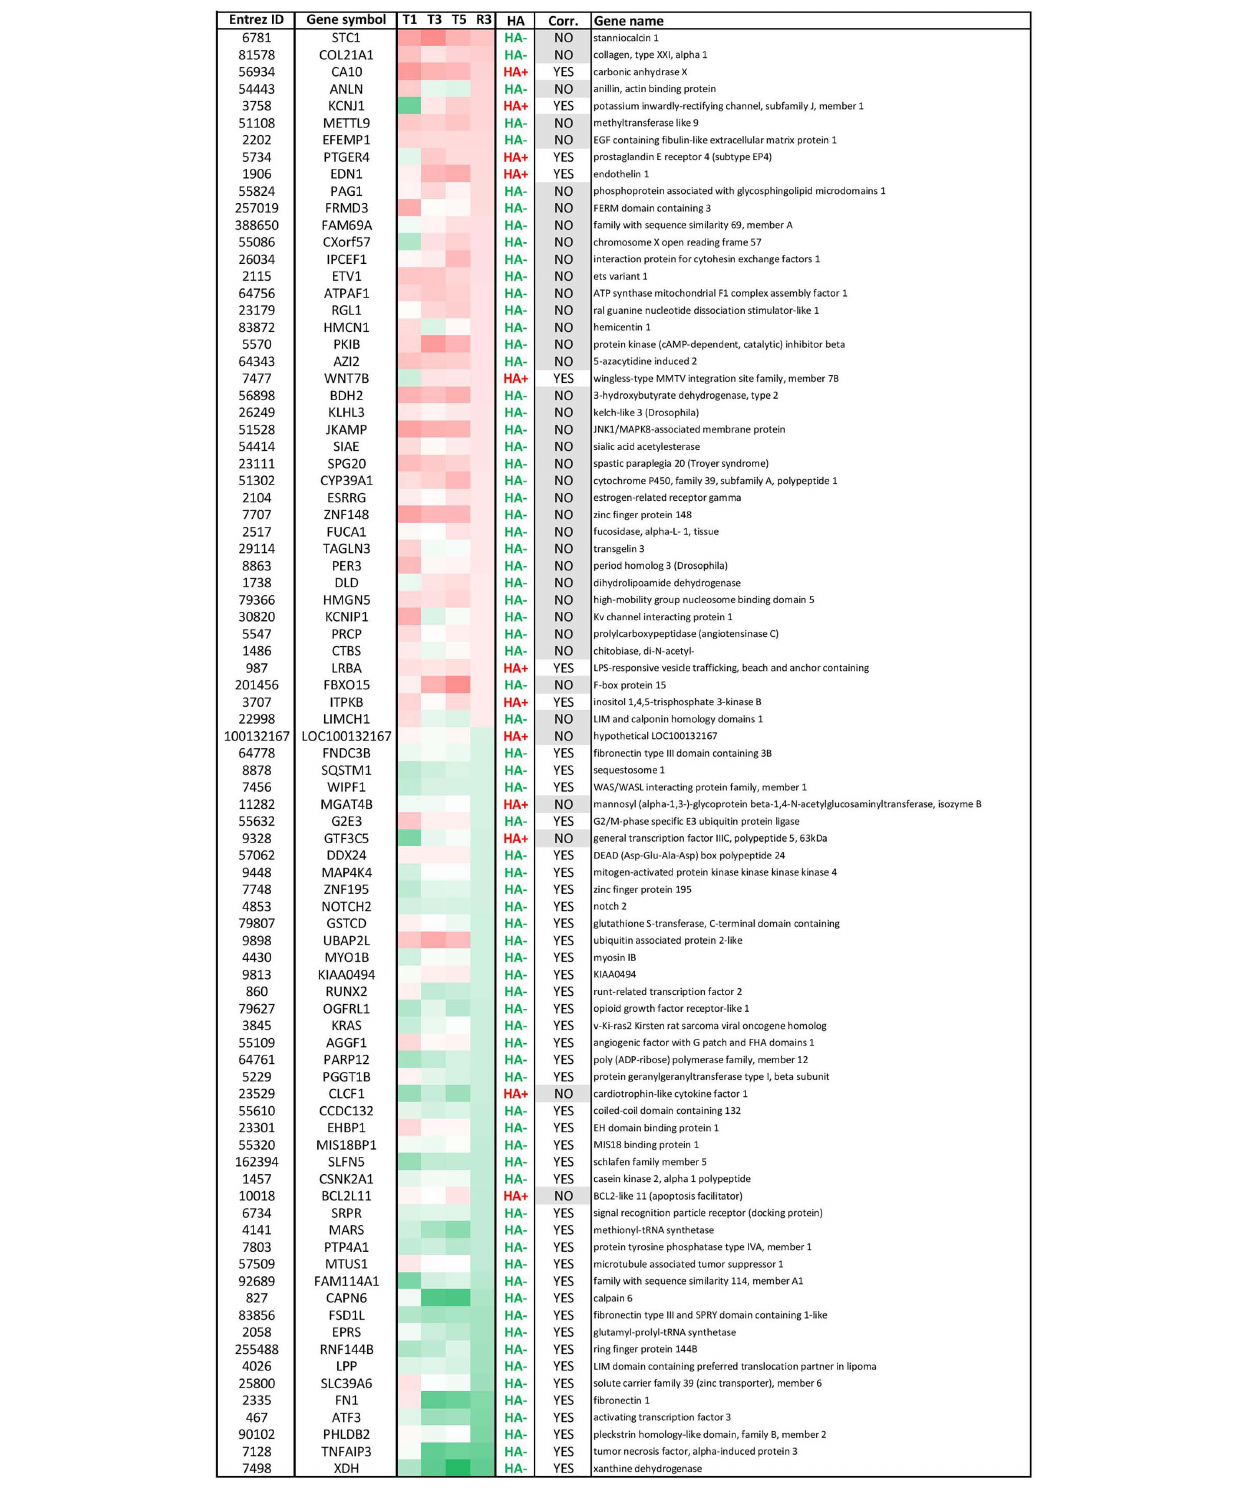
Frontiers in Genetics |